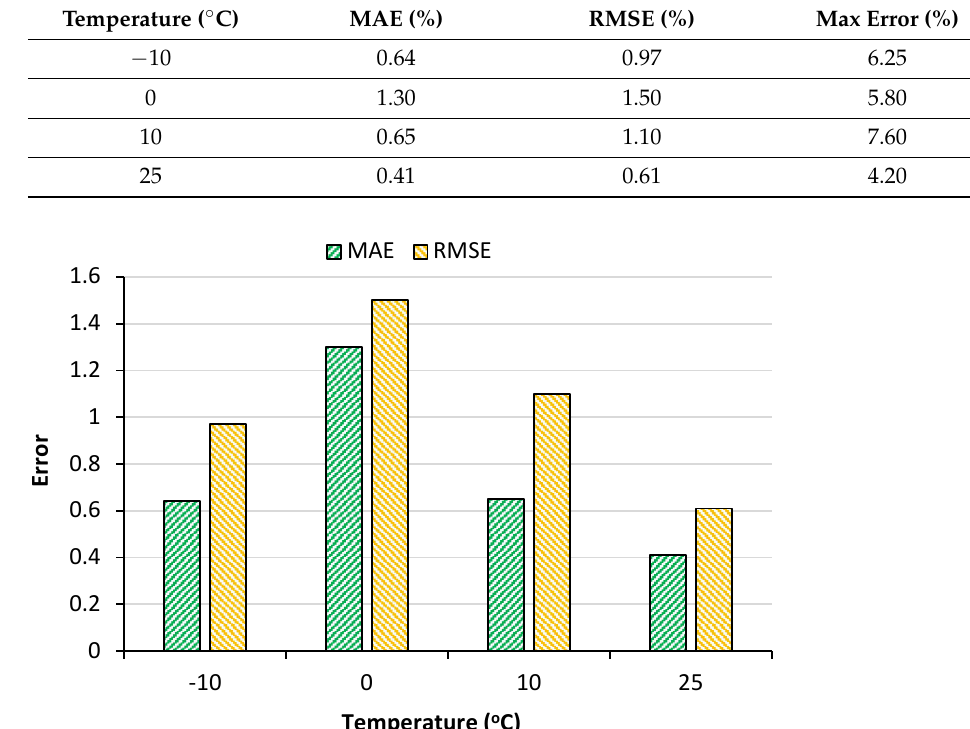
Figure 17. MAE and the RMSE of the CNN-GRU-LSTM model in the four different temperatures.